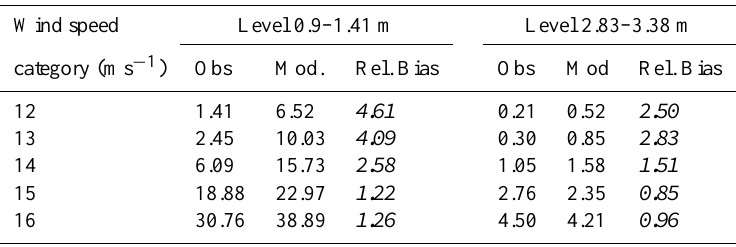
Fig. 10. Maps of snow cover evolution during northern blowing snow events around Col du Lac Blanc (black box on Fig. 9): (a) snow depth difference measured by TLS at an horizontal resolution of 1m between 28 February 2011 and 17 February 2011, (b) same as (a) but averaged at an horizontal resolution of 50m and (c) SWE difference simulated by Meso-NH/Crocus between 23:00 and 01:00 on 18 March 2011. The arrow indicate example of snow deposition patterns discussed in the text. Note the difference of colourbars. The spatial coordinates are in m and the dashed isolines correspond to 1z = 10m. Table 4. Average blowing snow fluxes (10 − 4 kgm − 2 s − 1 ) simulated by the model (Mod.) and measured by SPC (Obs.) at two levels above the snowpack. Average fluxes have been computed for 5 categories of 2m wind speed. Relative bias (Rel. bias) appears in italic and is calculated as ratio of modelled and observed average